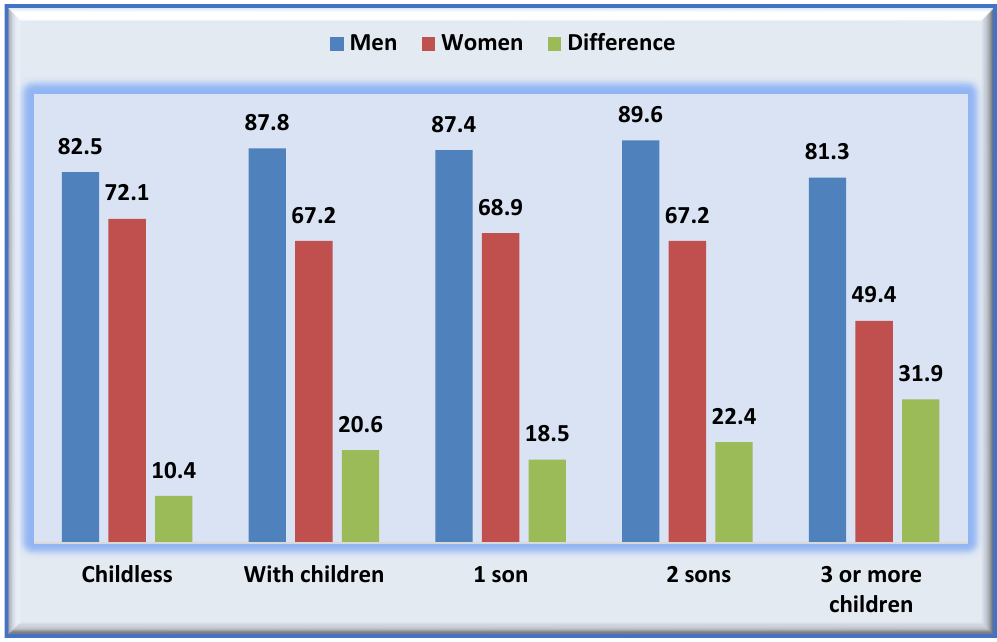
Figure 12. Percentage of employment rates by people sex aged 25 to 49 depending on whether or not they have children and the number of children under 12 years old. Source: Authors with data from the Labor Force Survey ( Encuesta de Población Activa ) corresponding to 2020 provided by the Statistics National Institute ( Instituto Nacional de Estadística ).